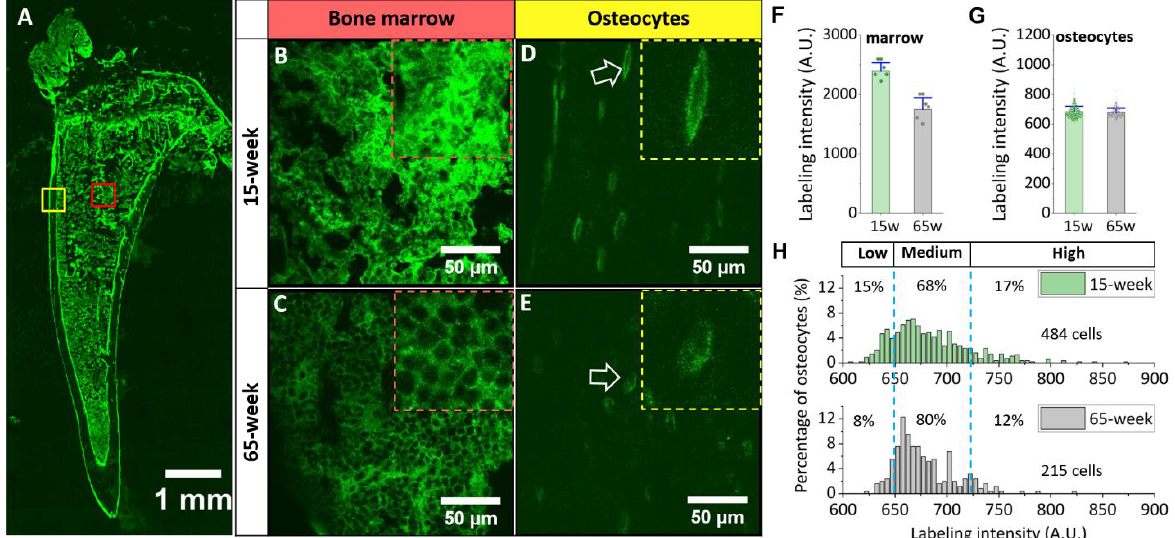
Figure 3. Different PCM labeling patterns in young vs. old bone. ( A ) A sagittal tibial section showed stronger green signals at the periosteum, endosteum, primary spongiosa, and marrow (red box) than in cortical bone (yellow box). ( B , C ) In mar- row bone, stronger signals were observed in young ( B ) than old ( C ) bones. ( D , E ) In tibial cortex, smooth halo-like labeling was observed around osteocytes (arrow) in young bone ( D ), while fluorescent labeling was punctuated in old bone ( E ). Magnified images are shown at the upper right corners of the pictures. PCM labeling intensity was higher in the marrow of young bone ( F ), and while no difference was detected between cortical osteocytes ( G ), the histograms and the percent- ages of osteocytes expressing low-PCM, medium-PCM, and high-PCM intensity differed in young vs. old bone ( H ).